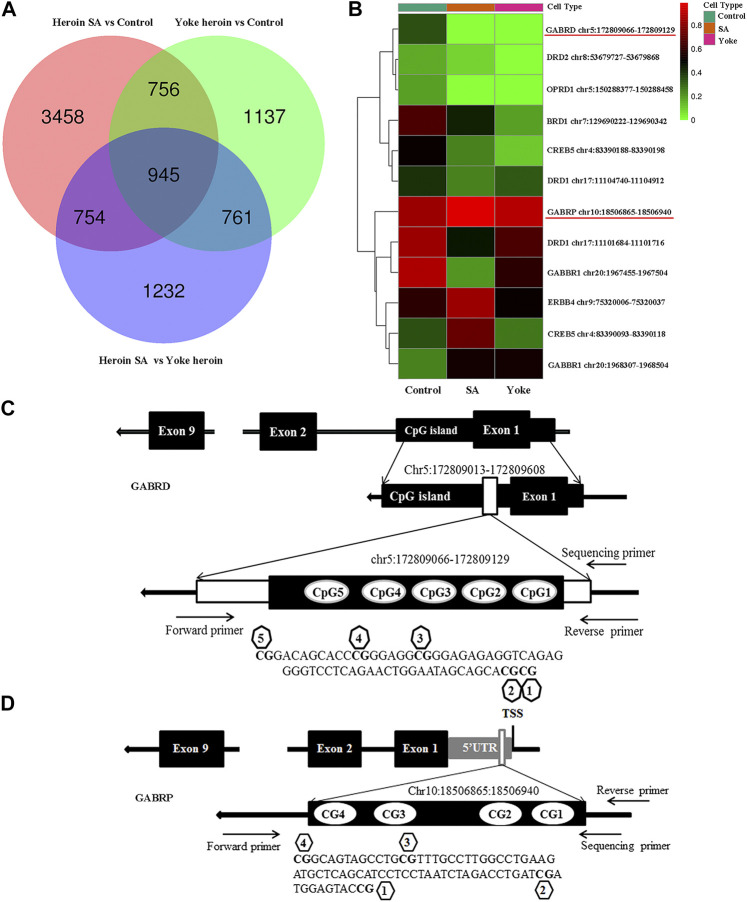
DNA methylation of heroin self-administration rats and the locations of target sequences. (A) Venn diagram of promoter-DMRs related genes in the paired comparison of the three groups of rats (n = 3 per group). SA: self-administration. (B) A hierarchical clustering map of NAc gene methylation for yoked-saline (control), heroin self-administration, and yoked-heroin rats (red, high methylation; green, low methylation). (C) The target sequence of GABRD is located in a CpG island which contains 5 CpG sites. (D) The target sequence of GABRP is located in the 5′UTR which contains four CpG sites. SA: Self-administration, Control: yoked-saline group.